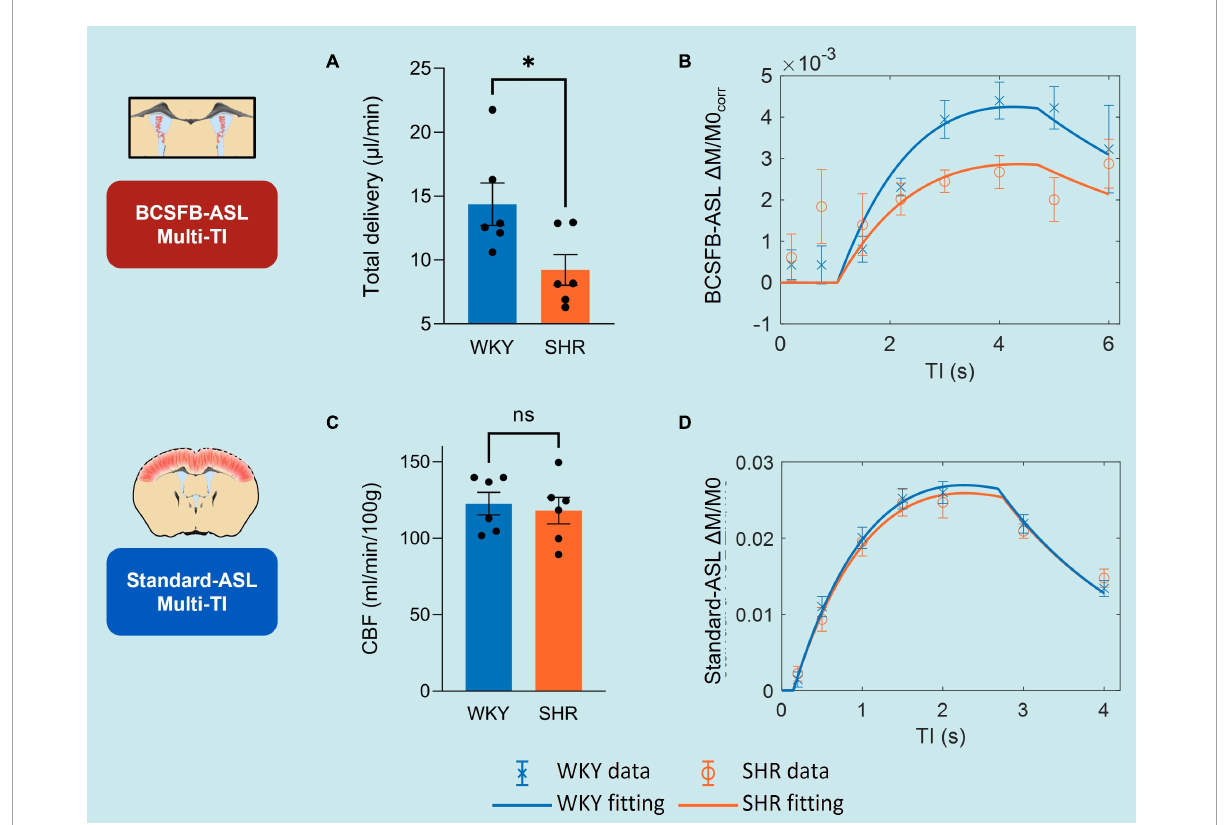
FIGURE2 Multi-TI kinetic data for BCSFB-ASL and Standard-ASL. (A) Extracted BCSFB-mediated total water delivery in WKY and SHR subjects. (B) Averaged BCSFB-ASL multi-TI data alongside kinetic curve fits for WKY and SHR subjects. (C) Extracted cortical CBF in WKY and SHR subjects. (D) Averaged standard-ASL multi-TI data alongside kinetic curve fits for WKY and SHR subjects. Error bars: ± SEM ( n = 6 WKY, 6 SHR). Asterisks: 2-tailed t -test significance, * p < 0.05, ** p < 0.01, *** p < 0.001, and **** p <